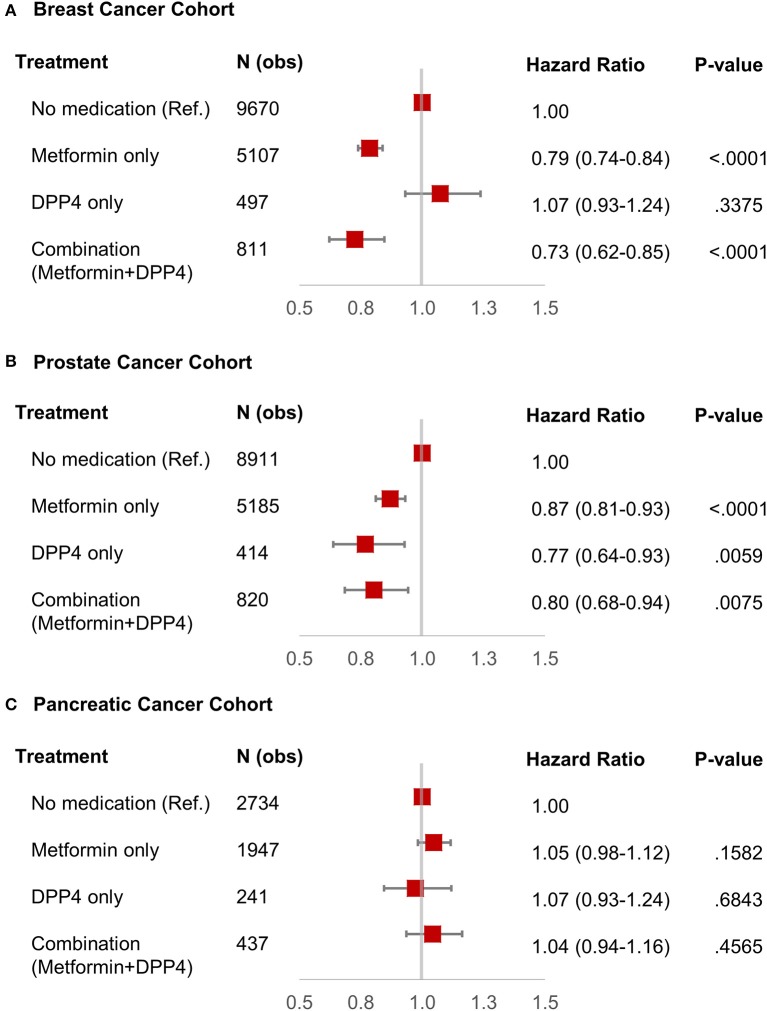
Forest plot with hazard ratio showing survival analysis of breast cancer (A), prostate cancer (B), and pancreatic cancer (C) patients.